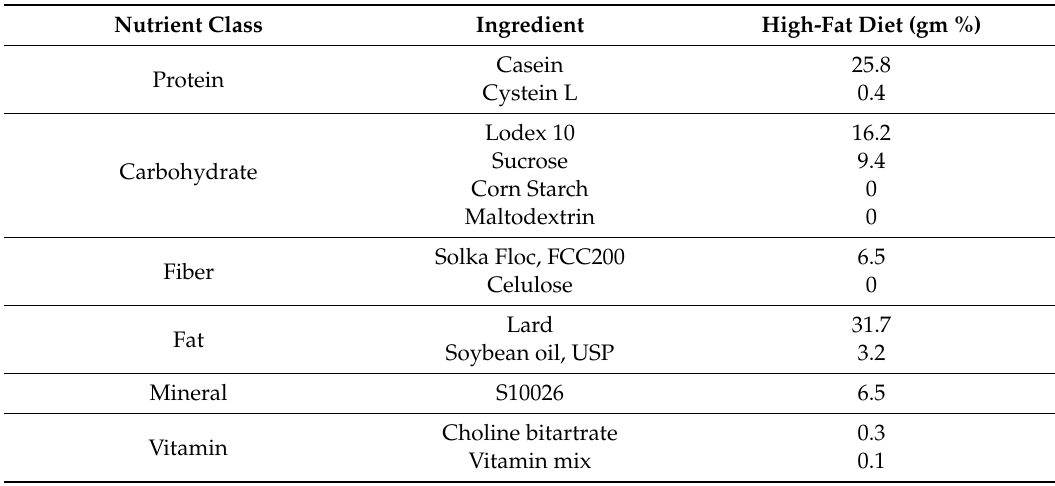
Table 2. Nutritional composition of the fat-rich animal fodder (high-fat diet) used throughout the study—Provider: Research Diets Inc. ([29], #D12492).